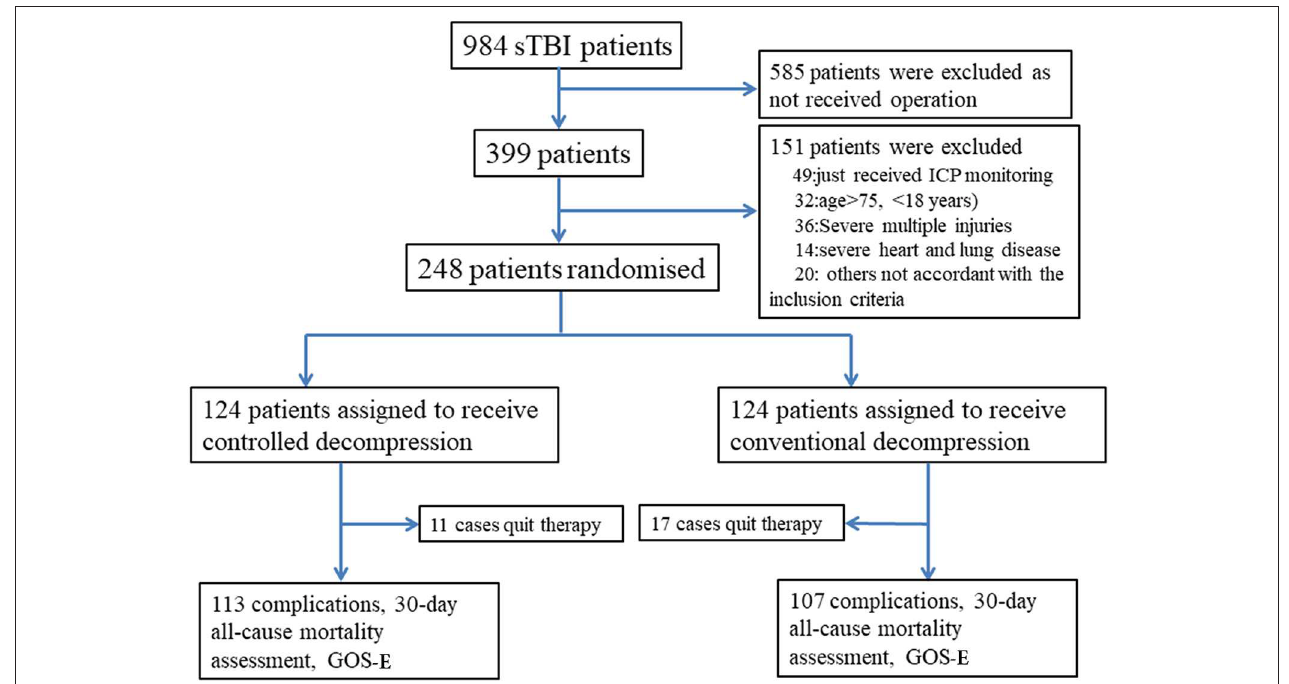
FIGURE 1 | CONSORT diagram of the